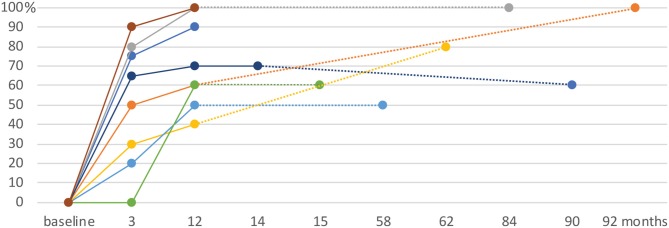
Pain relief in % as rated by the patients over time (months), from baseline to the last follow-up. Intervals between consultations of more than 12 months are connected with dotted lines.